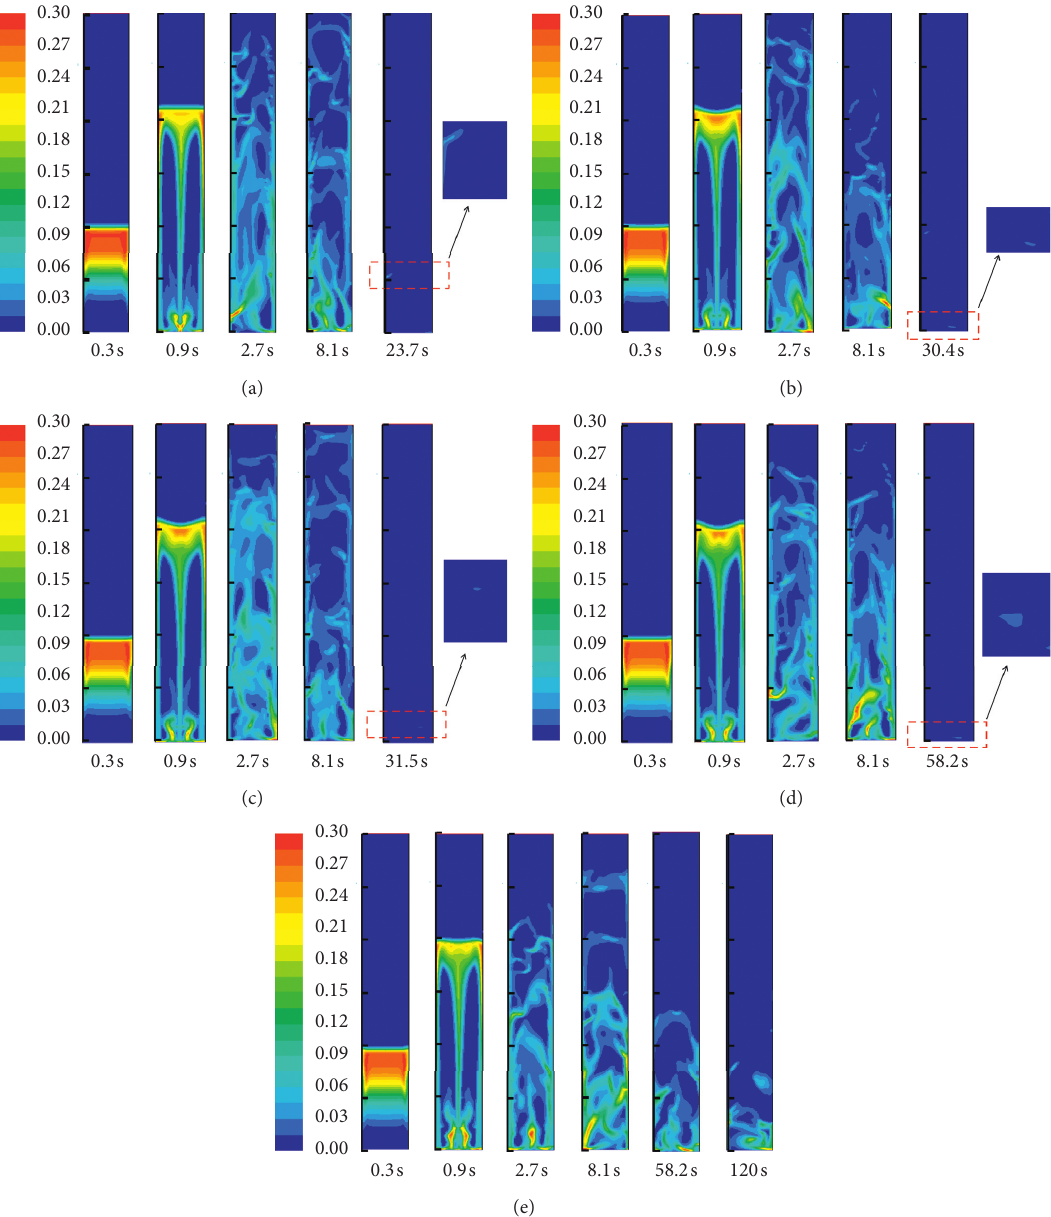
Figure 14: Volume fraction of dust: d � 0.18mm and u � 0.70m/s. (a) ρ � 1100kg/m 3 . (b) ρ � 1200kg/m 3 . (c) ρ � 1300kg/m 3 . (d) ρ � 1400kg/m 3 . (e) ρ � 1500kg/m 3